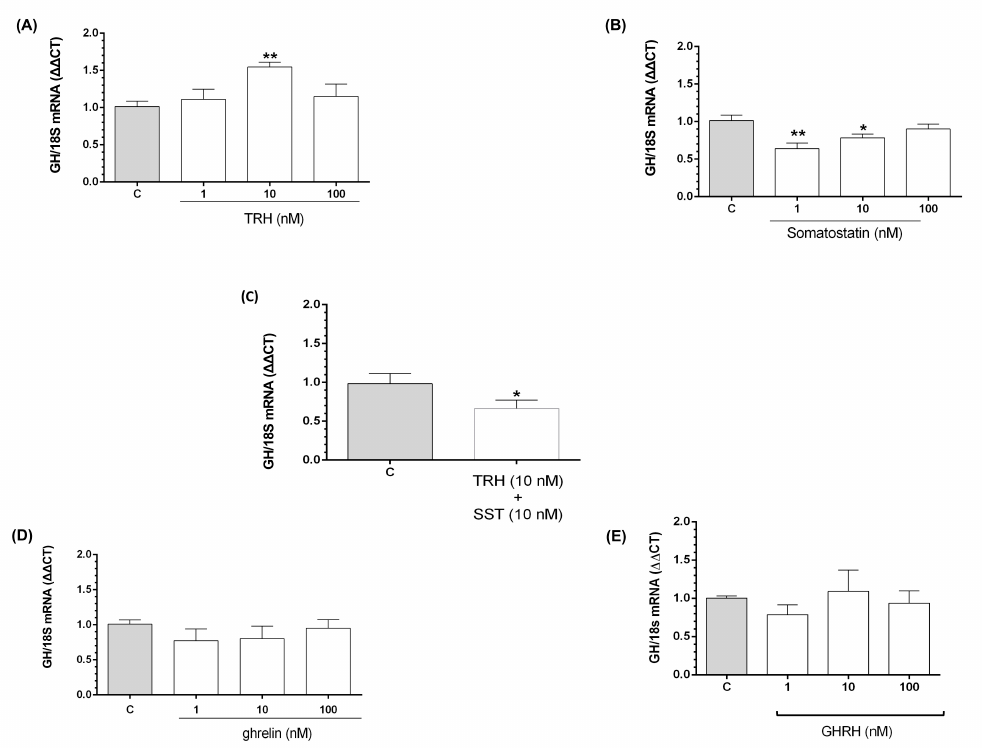
Figure 4. TRH, ghrelin, GHRH, and somatostatin (SST) effects upon GH mRNA expression in BBLs. After one-hour treatment with 1, 10 and 100 nM of either TRH ( A ), SST ( B ), ghrelin ( D ), GHRH ( E ), or the combination of 10 nM of both TRH and SST ( C ), the relative GH mRNA expression was determined by qPCR and corrected by the threshold cycle (CT) using the formula 2 − ∆∆ CT [29,30]. Ribosomal 18S RNA was used as reference gene. Each bar represents mean ± SEM. Data were obtained from three independent experiments analyzed by duplicate. Asterisks indicate significant di ff erences compared with control groups (* p < 0.05; ** p < 0.01), by using one-way ANOVA for multiple comparisons and Šid á k as post-hoc test. A paired t test was used to evaluate the e ff ect of TRH in combination with SST (* p <